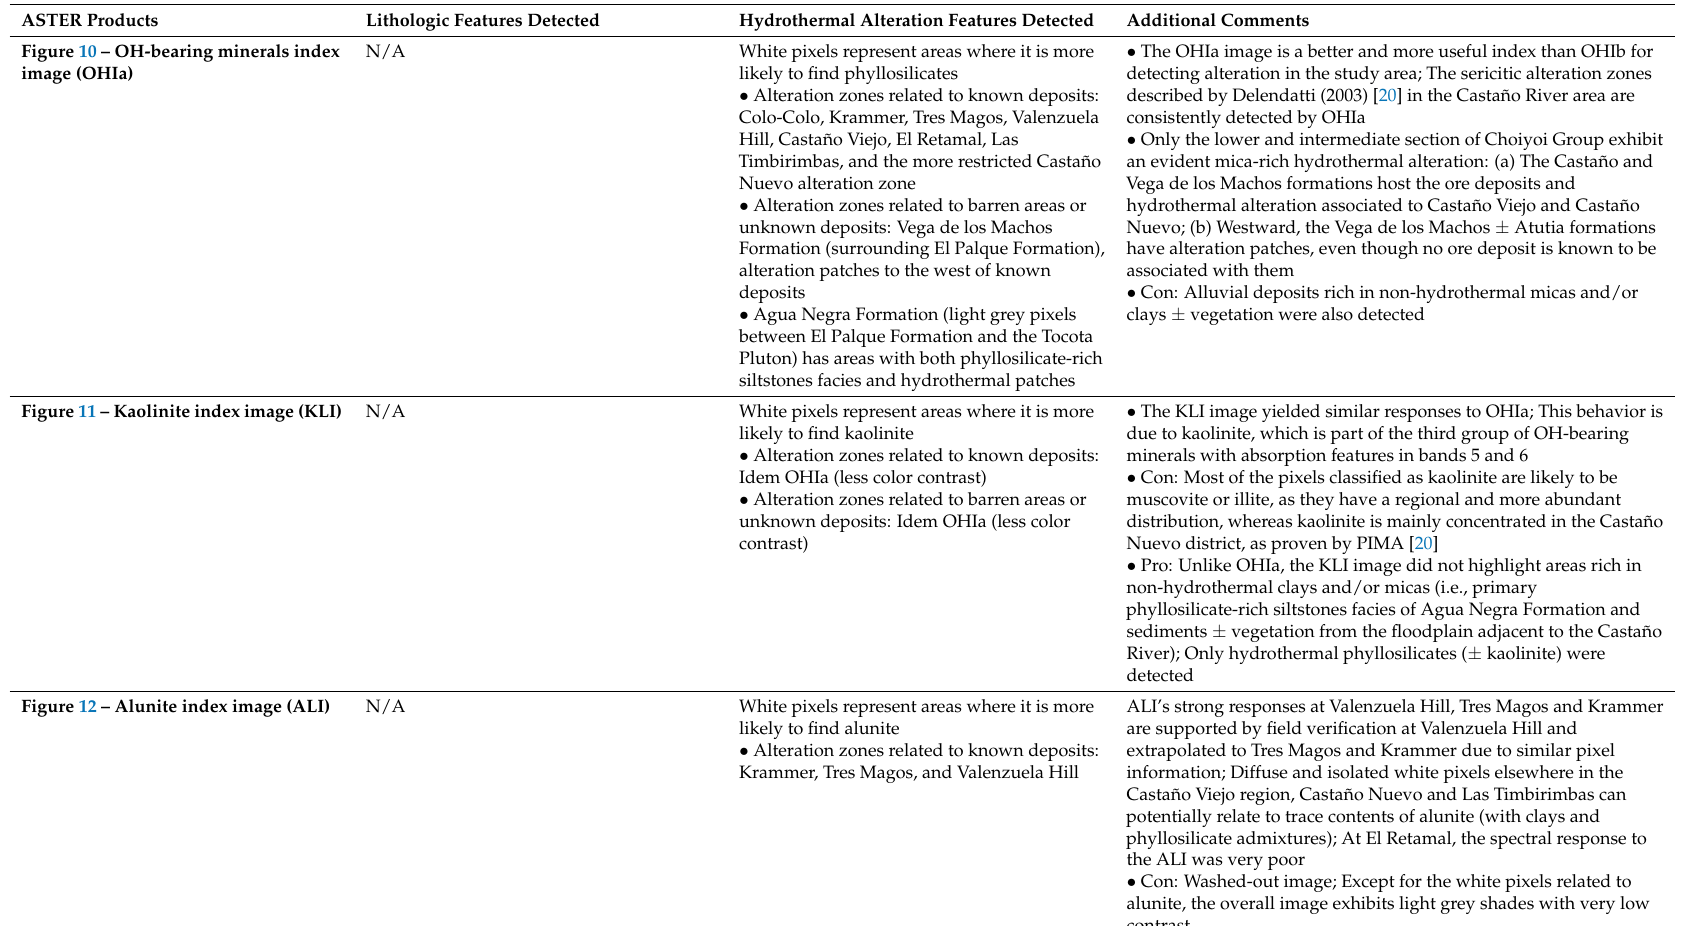
Figure 12 – Alunite index image